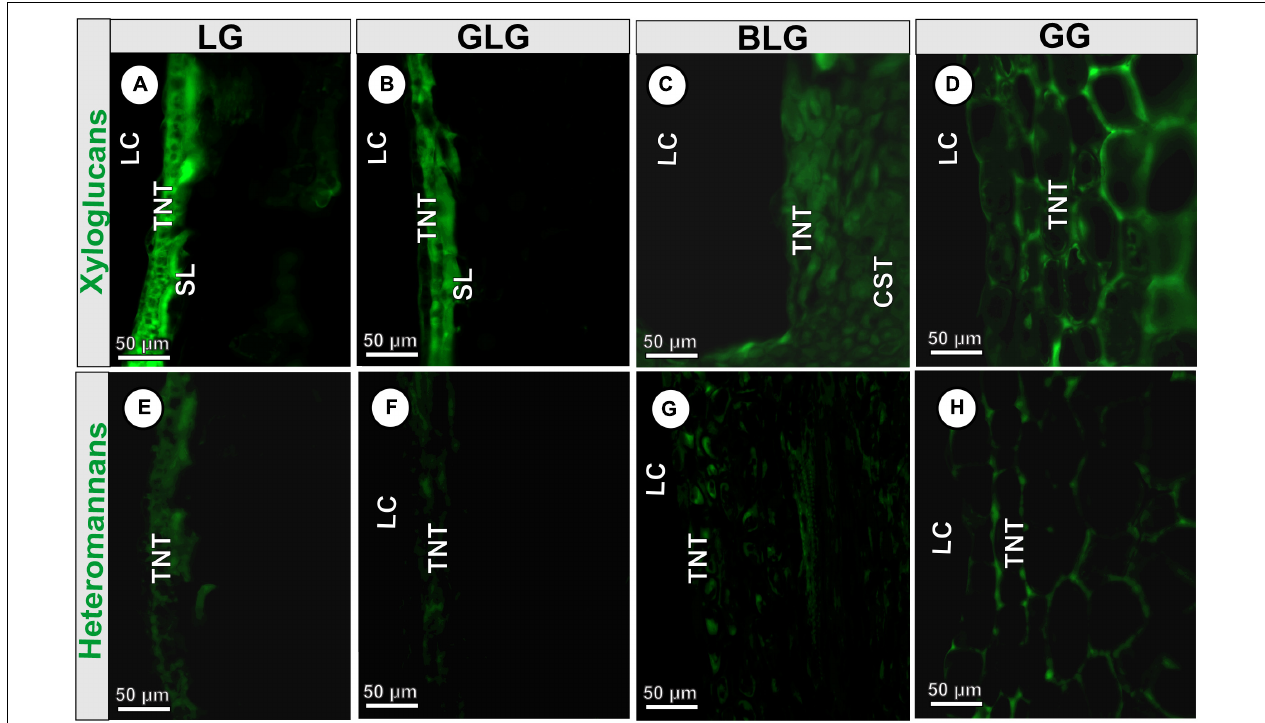
FIGURE 5 | Immunocytochemical profiles of the four Lopesia galls on Mimosa gemmulata Barneby (Fabaceae) pinna-rachis in transverse sections. (A–D) Xyloglucans labeled by LM15. (E–H) Heteromannans labeled by LM20. BLG, brown lanceolate bivalve-shaped gall; CST, common storage tissue; GG, globoid bivalve-shaped gall; GLG, green lanceolate bivalve-shaped gall; LC, larval chamber; LG, lenticular bivalve-shaped gall; TNT, typical nutritive tissue; SL, schlerenchymatic layer.